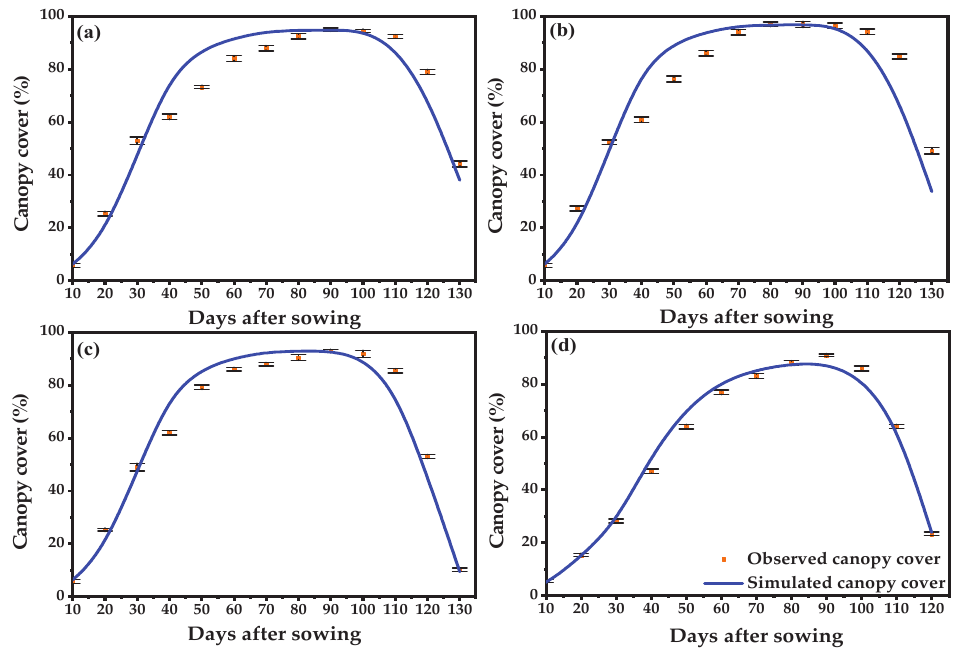
Observed canopy cover Simulated canopy cover Days after sowing Figure 6. Observed and simulated average canopy cover during the calibration period (2019) under four irrigation regimes. FI, flood irrigation ( a ); 3IF, 3-day irrigation frequency ( b ); 6IF, 6-day irrigation frequency ( c ); and 10IF, 10-day irrigation frequency ( d ). Error bars indicate standard deviation among the three replicates.